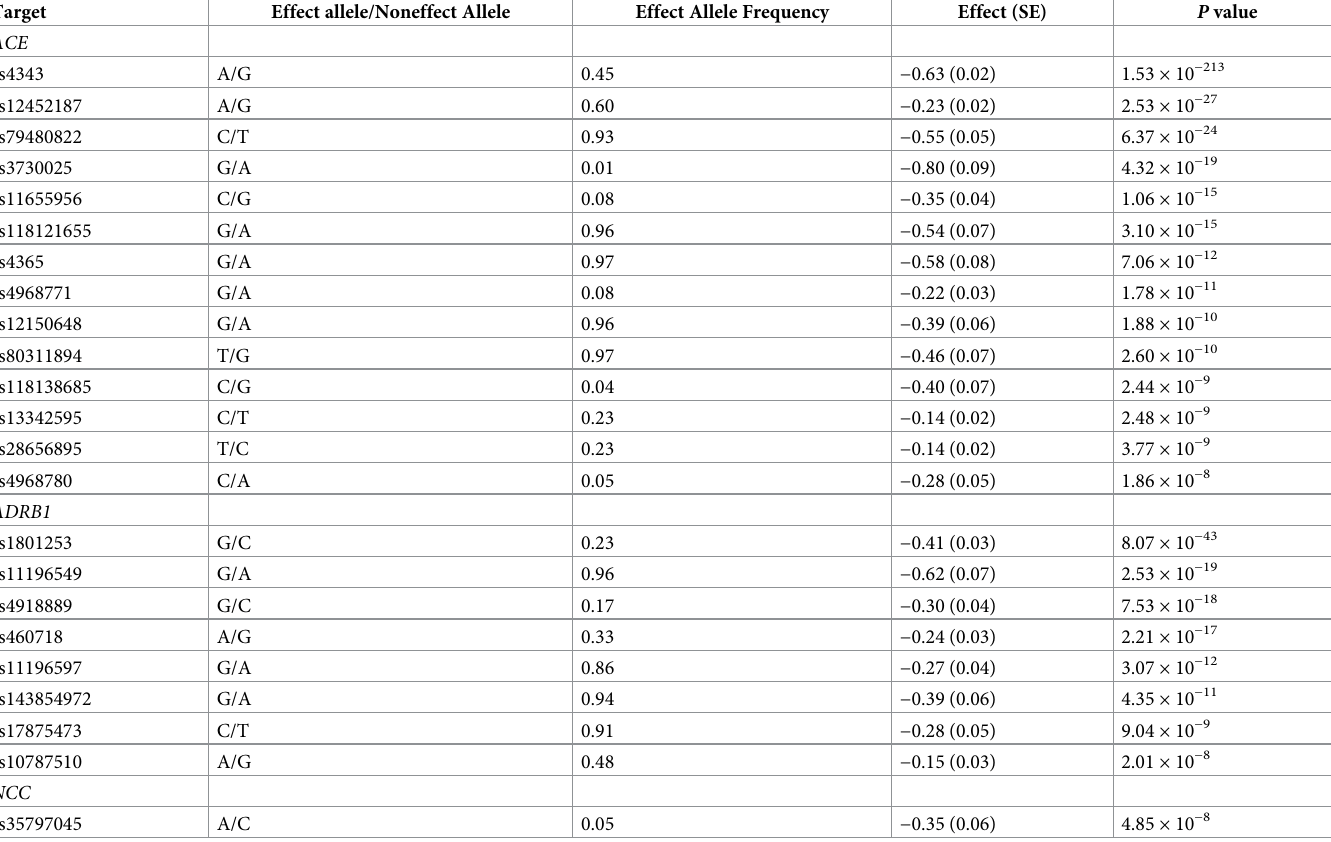
Table 1. Characteristics of SBP lowering genetic variants in ACE , ADRB1 , and SLC12A3 .